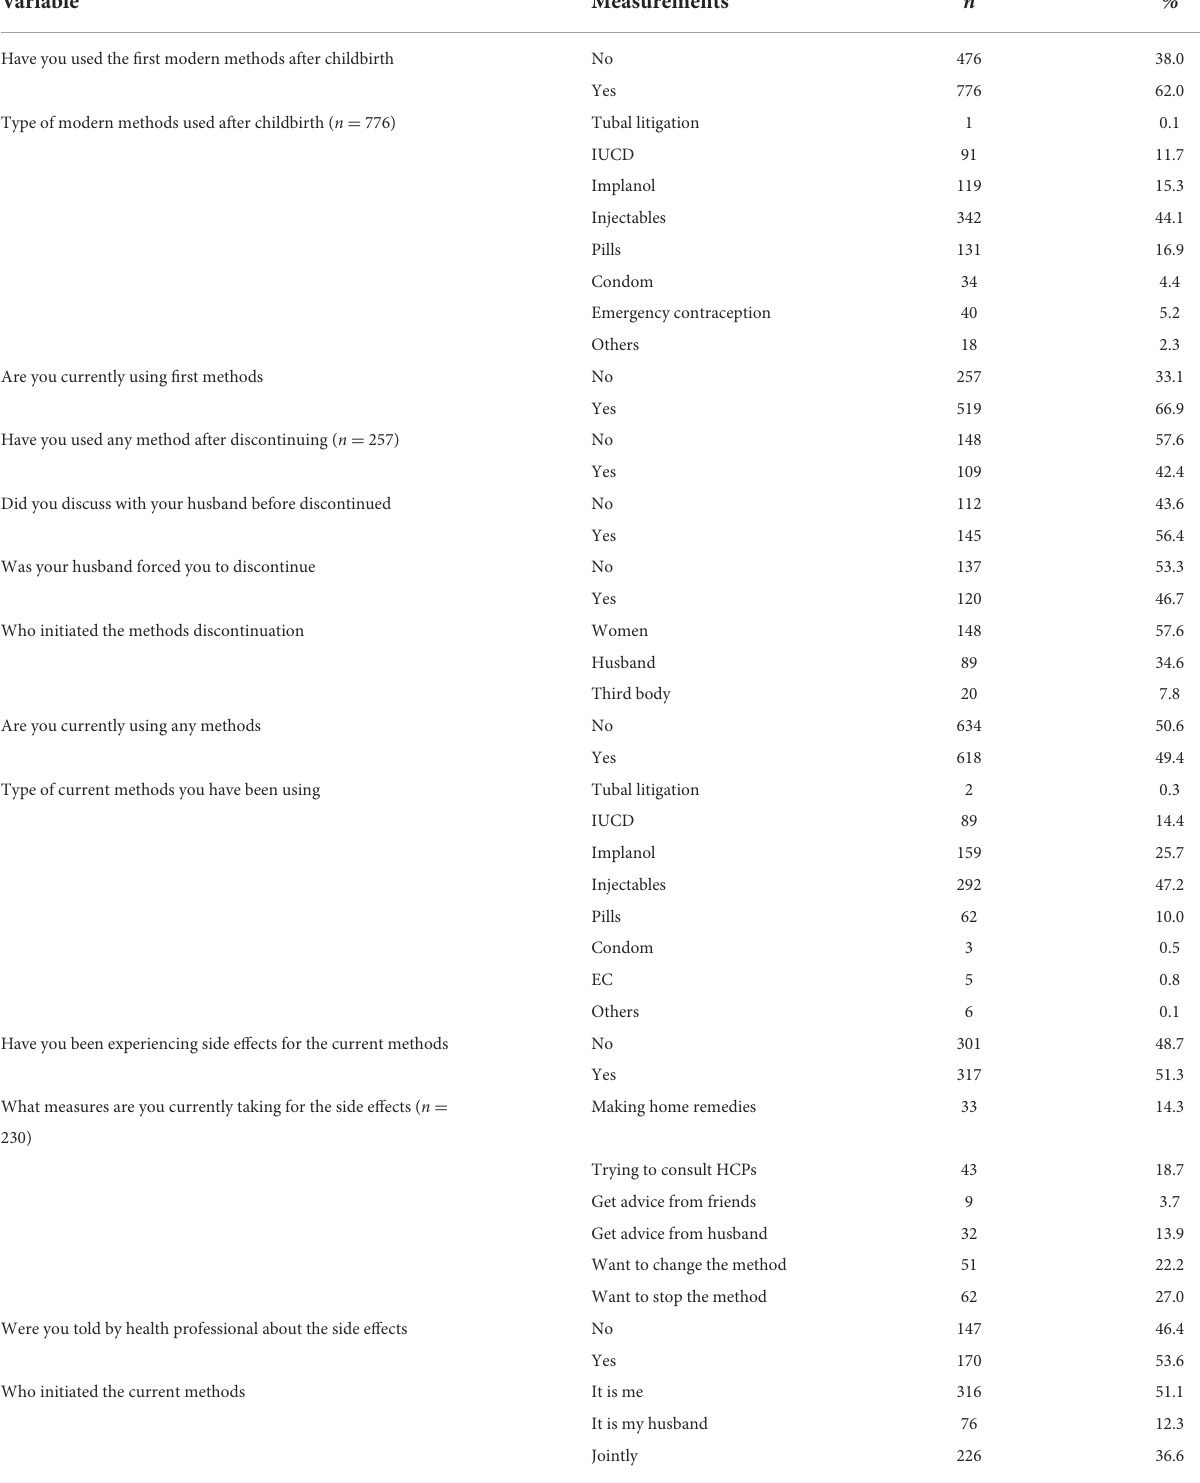
TABLE 2 Postpartum women’s contraceptive use dynamics among currently married women in Wolaita zone, South Ethiopia.